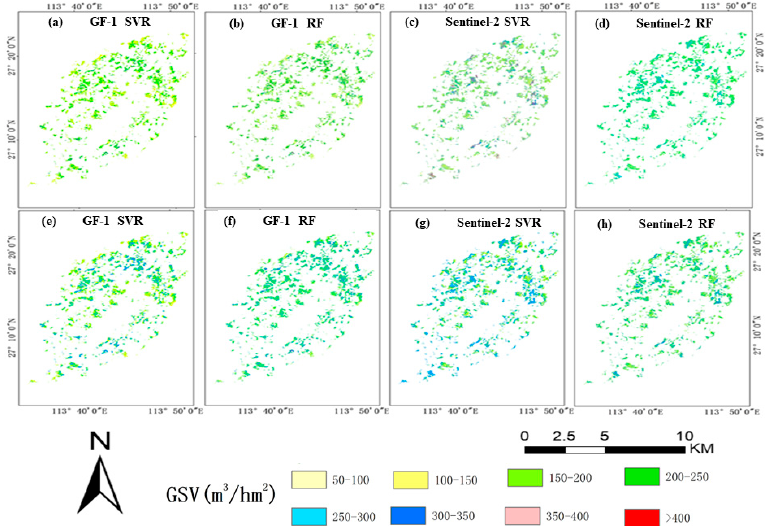
Figure 8. Map of forest GSV with SVM and RF from GF-1 and Sentinel-2 images. ( a – d ) show the results using Pearson correlation and ( e – h ) show the results using the proposed